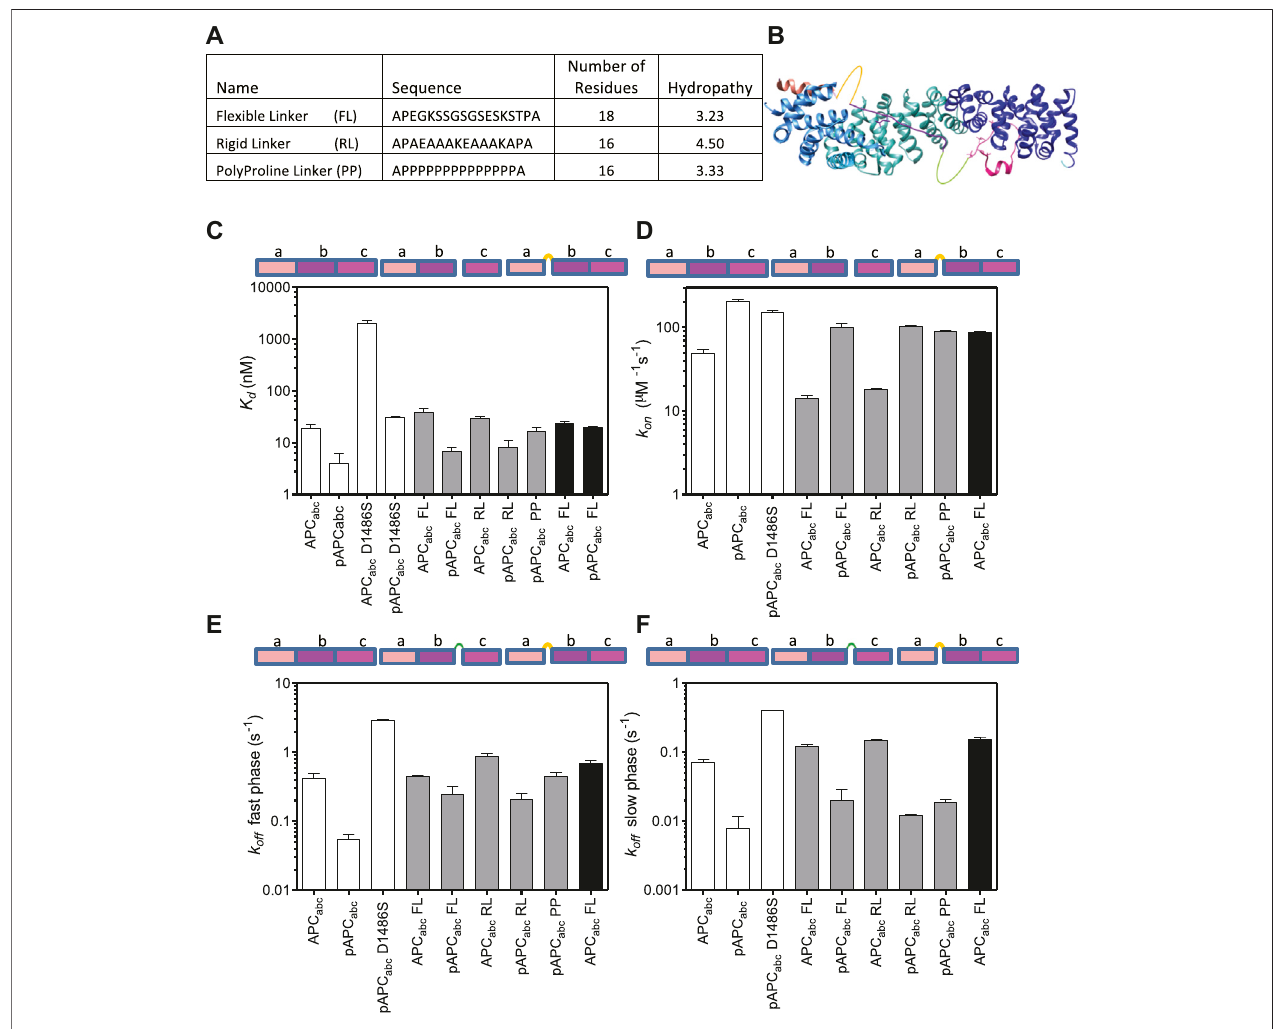
FIGURE6 | The effect oflinker insertions and mutationof thelysine-interaction residue D1486Sin APC on β -catenin-binding. (A) The sequences and propertiesof thelinkersinsertedintoAPC abc .Thehydropathywascalculatedusingmeanhydropathyofasequence(KyteandDoolittle,1982). (B) Schematicshowingthetwositesof linkerinsertionsinAPC. (C) Dissociationconstantsweremeasuredby fl uorescenceanisotropyoftheAPCvariantslabelledwith fl uoresceinatCys1501,andthedataare shown as the mean ± SEM of three replicates. (D) The association rates and the rates of the two dissociation phases, fast (E) and slow (F) , were measured by stopped- fl ow fl uorescence. The data shown are the mean ± SEM of at least two replicate experiments consisting of fi ve kinetic traces at each concentration